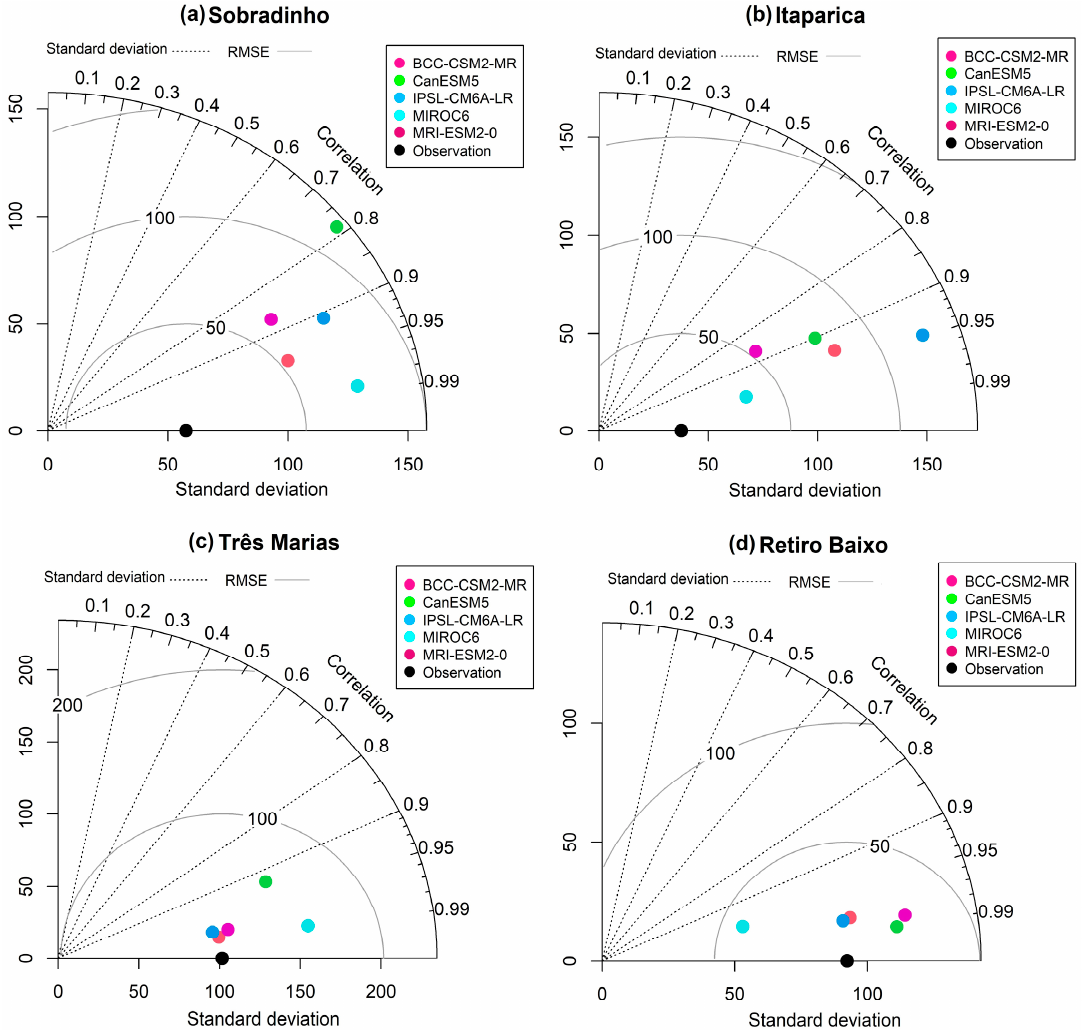
Figure 6. Taylor Diagram of the precipitation seasonality of the CMIP6 models BCC-CSM2-MR, CanESM5, IPSL-CM6A-LR, MIROC6 and MRI-ESM2-0 in relation to observed data.